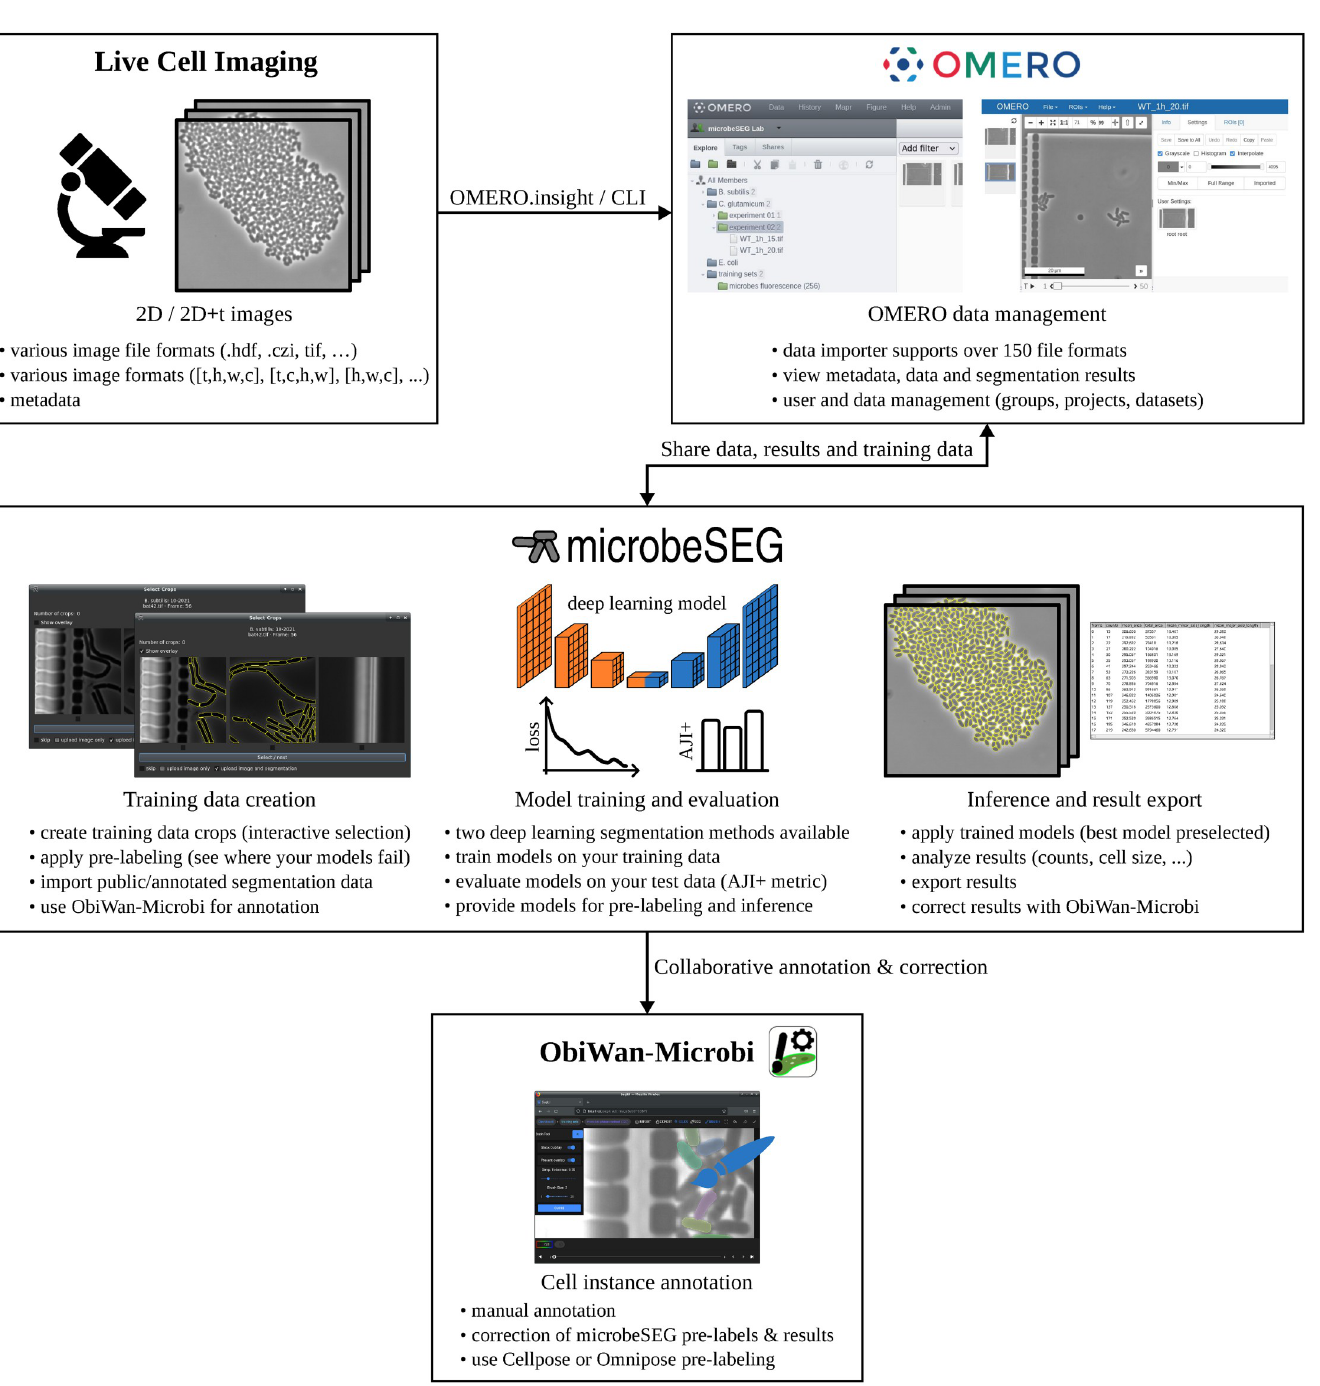
Fig 2. microbeSEG overview. OMERO is used for data management since it provides a versatile data importer and standardizes file handling [15]. Data can be viewed in the browser with the OMERO.web client. microbeSEG offers training data creation, training, evaluation, and inference functionalities. The jointly developed toolkit ObiWan-Microbi is used for manual annotation and result correction [18].